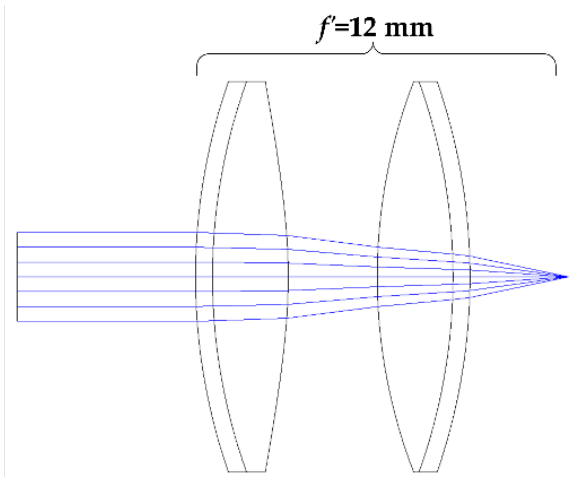
In order to extend the scan angle to a greater extent, the focal length of the collimating lens group is determined to be 12 mm. The collimating lens group is composed of two approximately symmetrical doublet lenses. Its two-dimensional structure is shown in Figure 7. This structure can not only correct coma and astigmatism, but also has a compact structure and small field curvature.